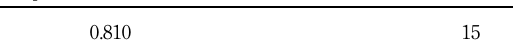
Table 2. Reliability